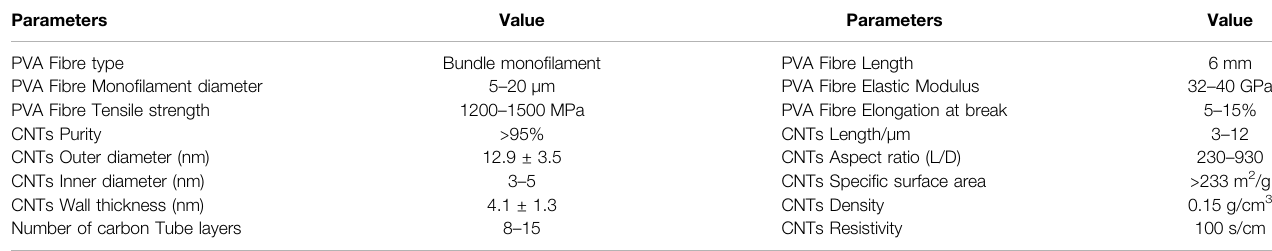
TABLE 2 | Main performance parameters of PVA fi bre and multi-walled CNTs. Parameters Value